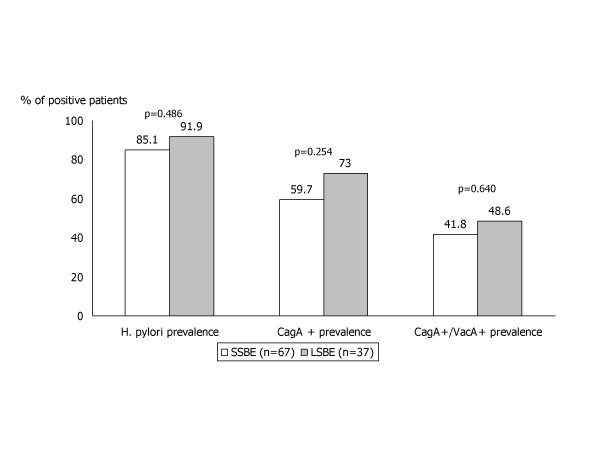
H. pylori infection related to age.